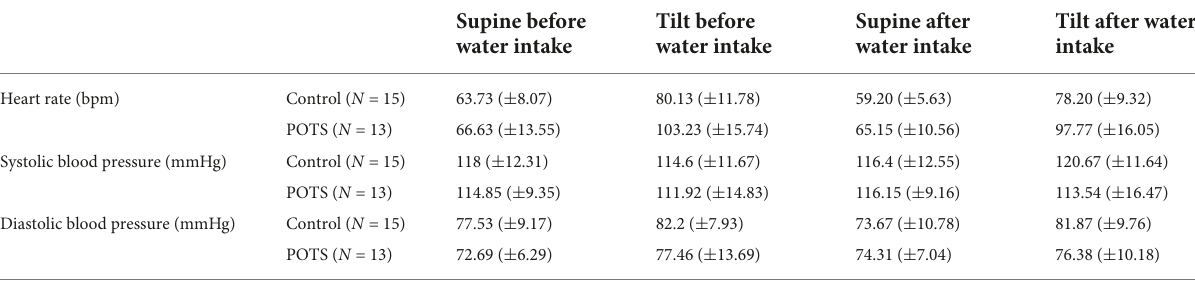
TABLE 2 Results of cardiovascular autonomic function